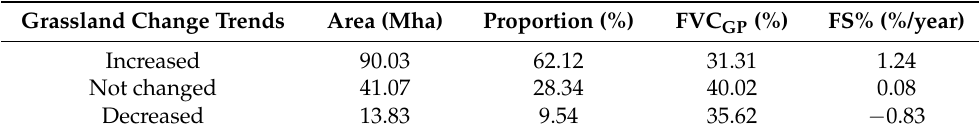
Table 3. Area, proportion, FVC GP and FS% of different grassland change trends in the Tibetan Plateau (TP) during 2000–2019.